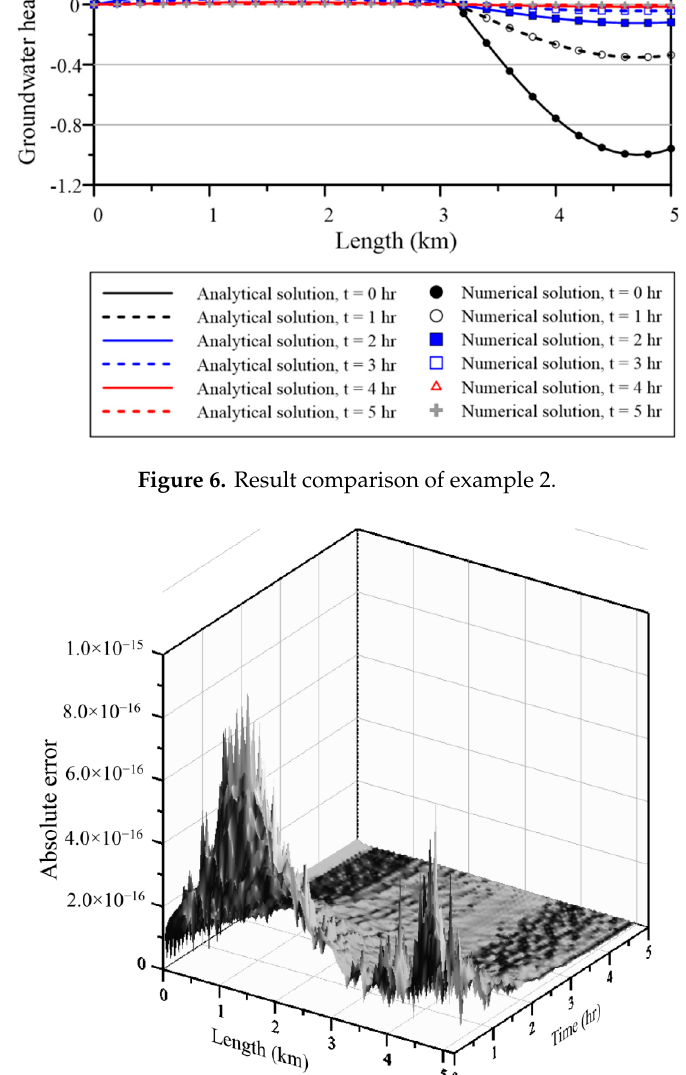
Figure 7. Absolute error at final time.